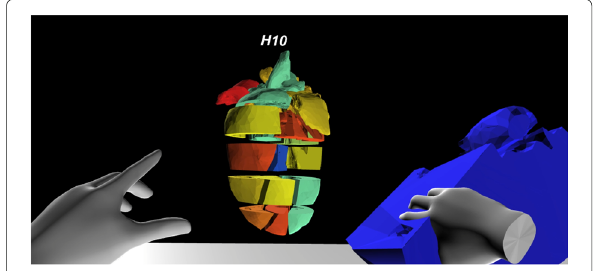
Fig. 1 HMD-VR environment with the interaction of a single slice of the heart